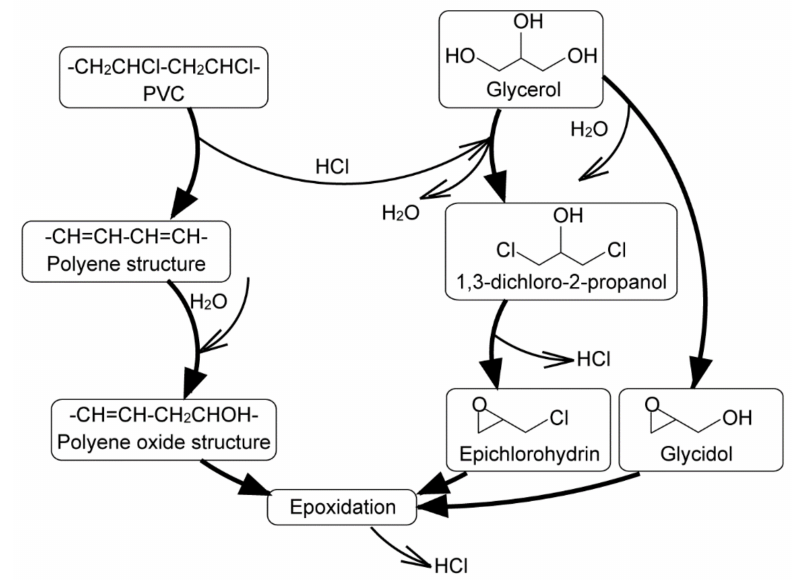
Figure 6. Schematic of dechlorination reaction of PVC in